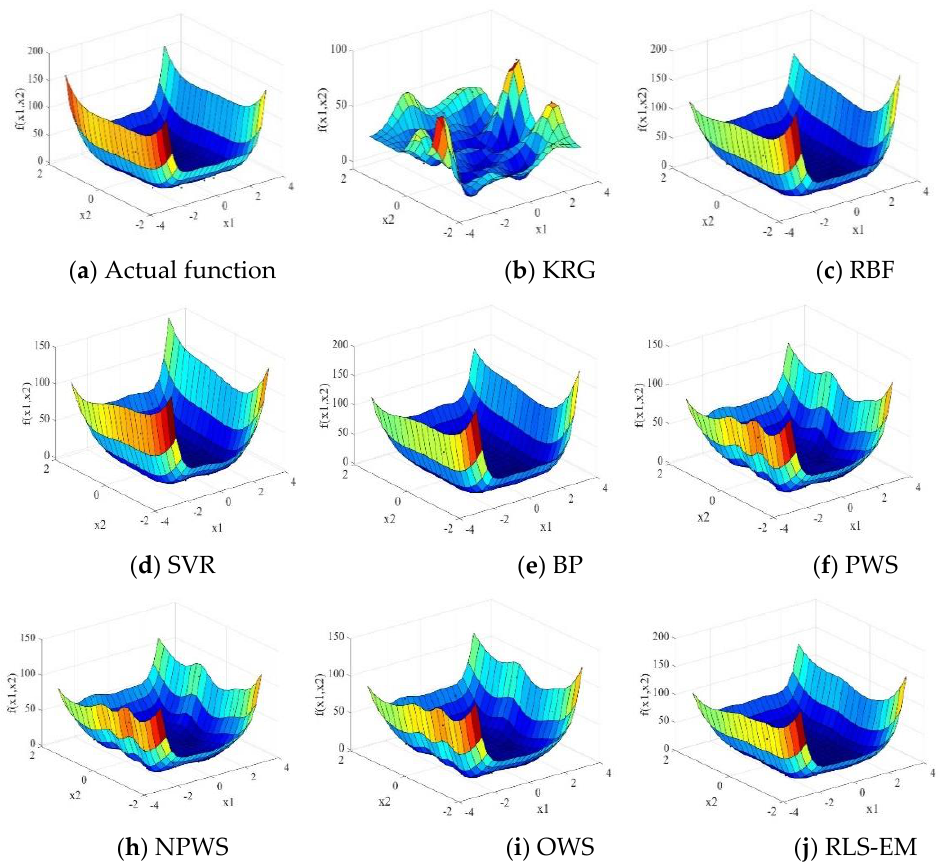
Figure 2. Surface plots of the Camelback function.